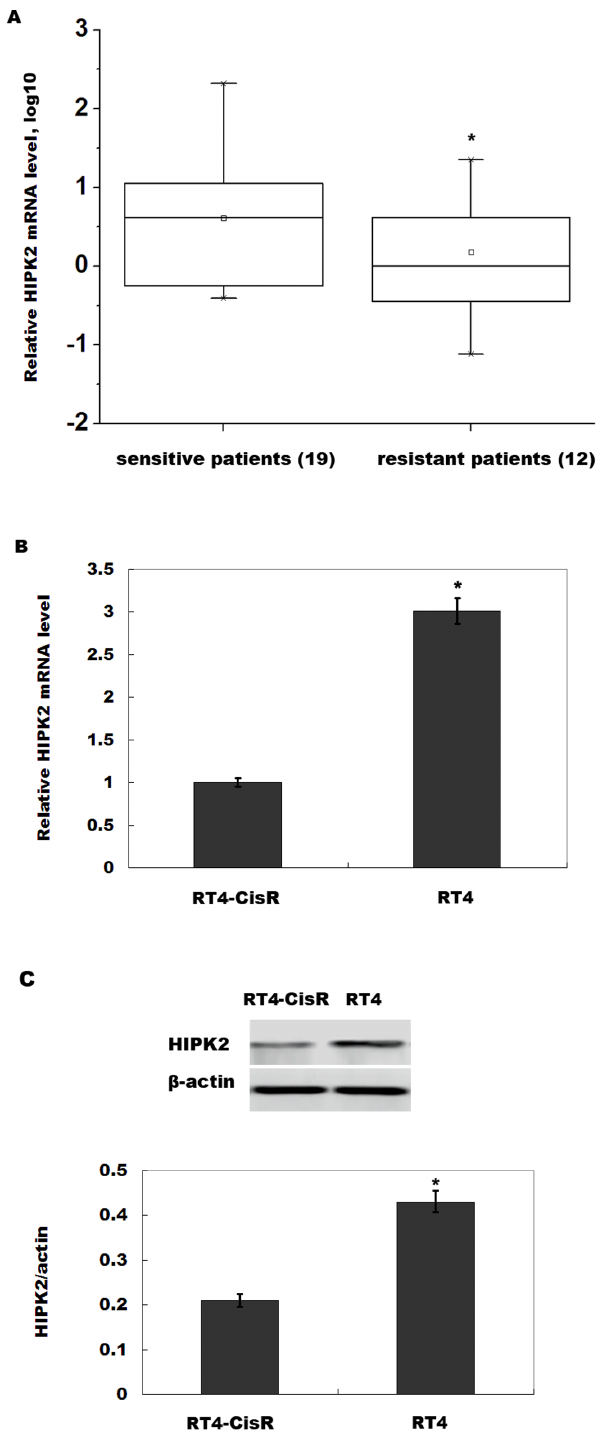
Figure 1. HIPK2 expression is decreased in chemo-resistant bladder cancer cell. (A) The analysis of the HIPK2 expression level was performed in blood samples with cisplatin-sensitive patients (n=19) and cisplatin-resistant patients (n=12). Total RNA was extracted and subjected to real-time RT-PCR to analyze the relative level of HIPK2 in each sample. Relative expression was calculated and normalized with respect to b -actin mRNA. All data were expressed as fold change relative to a tissue (control, expression=1). The results were expressed as Log10 (2 2 DD Ct ). * p , 0.05. (B) The cisplatin-resistant subline RT4-CisR was established by continuous exposure to increasing